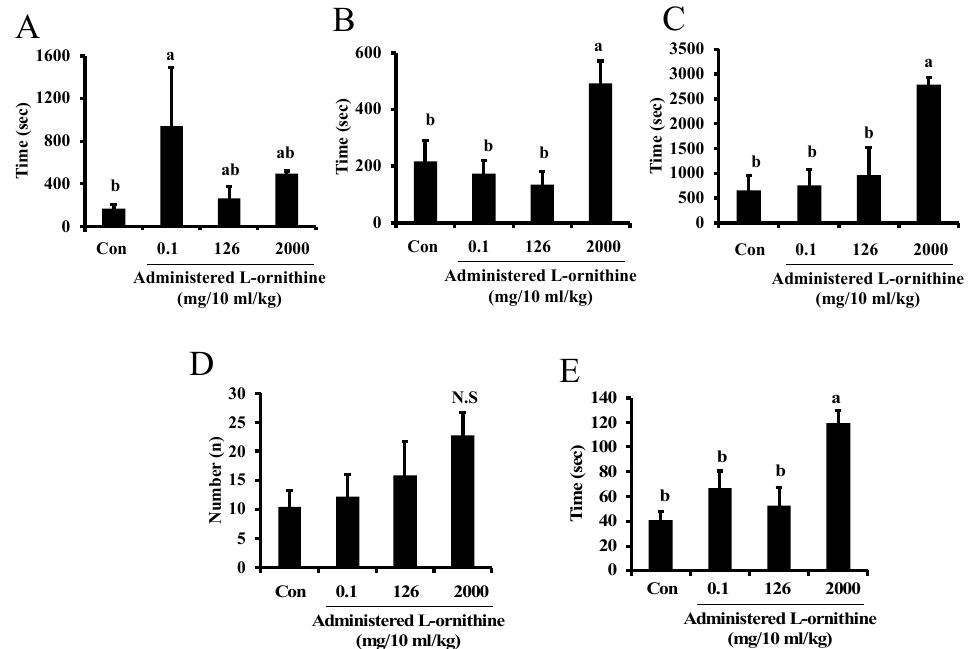
Figure 4. Sleep-like behavior of mouse pups supplemented with L-ornithine at different concentra- tions. Sleep latency ( A ), the longest sleep duration ( B ), total sleep time ( C ), sleep episode ( D ), and mean sleep duration ( E ) in pups at P14-16 in Experiment 3. Data are expressed as means ± SEM. n = 4–5/group. Con: control. The value marked with the letter “a” is significantly higher than the other values marked with the letter “b” at p < 0.05. If having common letters (a vs. ab or b vs. ab), it is not significantly different. N.S indicates no significant difference from control.